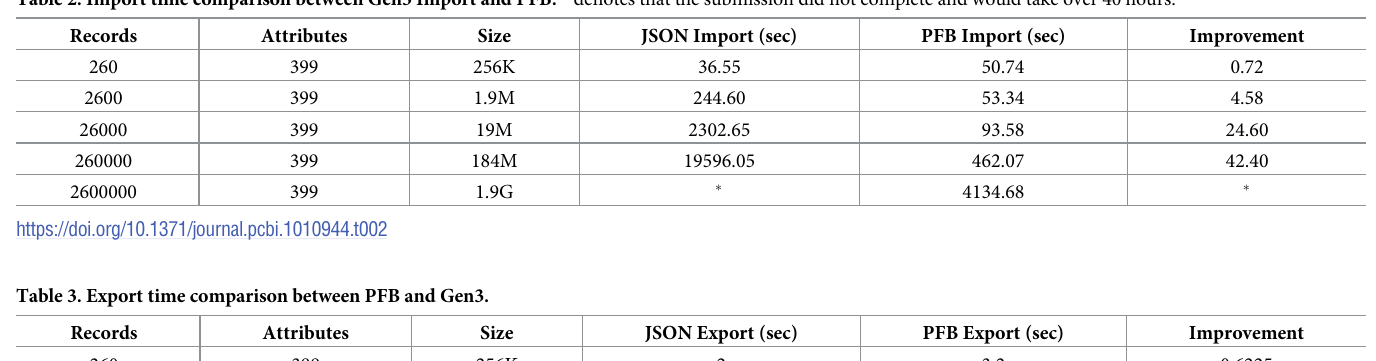
Table 2. Import time comparison between Gen3 Import and PFB. � denotes that the submission did not complete and would take over 40 hours.